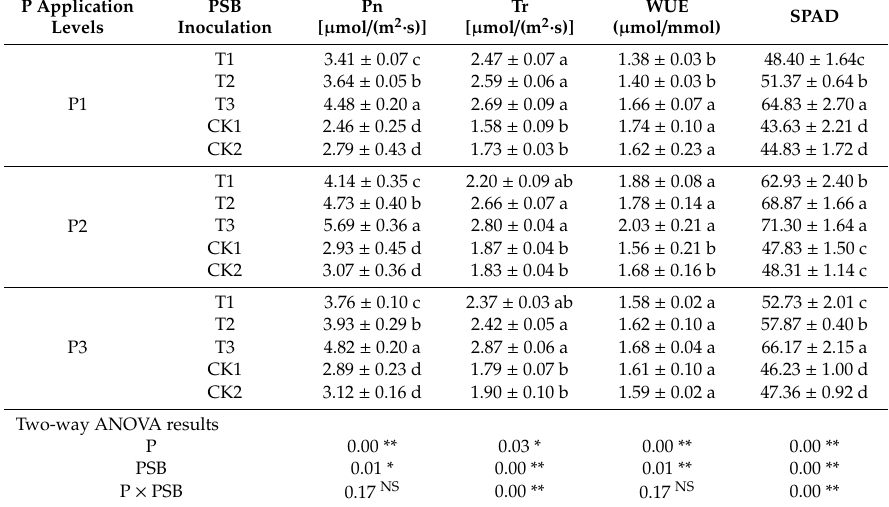
Table 2. E ff ect of PSB on the photosynthetic characteristics of C. oleifera leaves. P Application